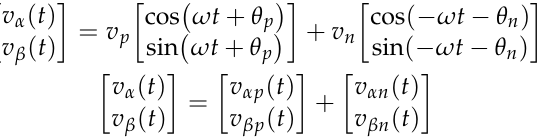
Figure 5. Phasor diagram of the resultant voltage from its sequence components.